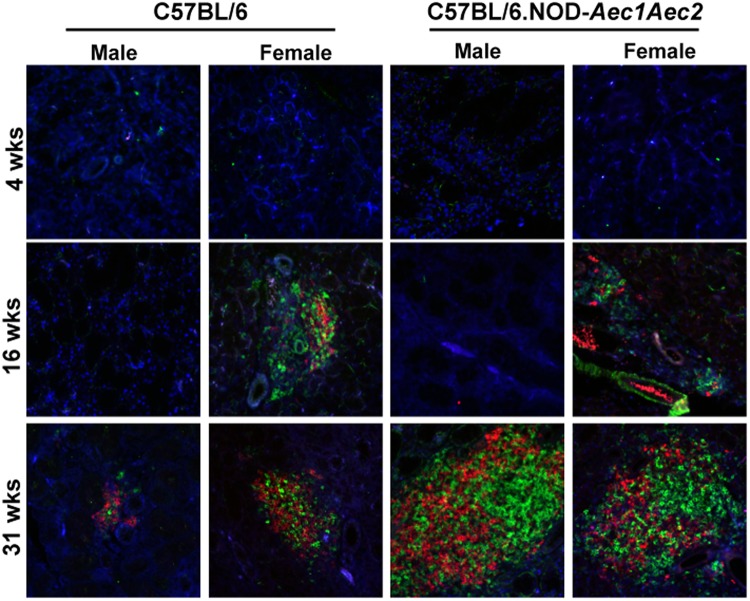
Presence of salivary glands-specific B and T cells. Male and female C57BL/6J.NOD-Aec1Aec2 at 4, 16 and 31 weeks old (males, n=4, 4 and 6; females, n=3, 3 and 9 for three ages respectively) and male and female C57BL/6 at 4, 16 and 31 weeks of age (males, n=7, 6 and 5; females, n=3, 6 and 8 for three ages respectively) were used. Salivary glands were excised and embedded in paraffin. Sections were cut and stained for CD3+ T cells [donkey anti-goat FITC against goat anti-mouse CD3 (green)] and B220+ B cells [donkey anti-rat IgG AF594 against rat anti-mouse (red)] with DAPI nuclei staining (blue). Images were captured on Nikon Ti-E fluorescent microscope. Representative images were shown at 200× magnification.